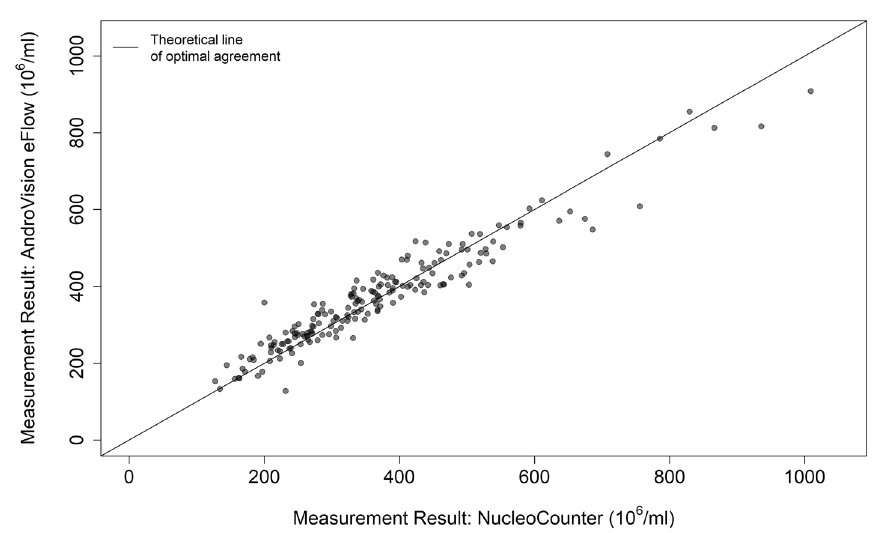
Figure 2. Method comparison of NUCLEOCOUNTER and eFlow sperm concentration of 185 raw boar ejaculates as measured in split samples with the NUCLEOCOUNTER as reference method and ANDROVISION eFlow. The Concordance Correlation Coefficient (CCC) of the method comparison was 0.955.